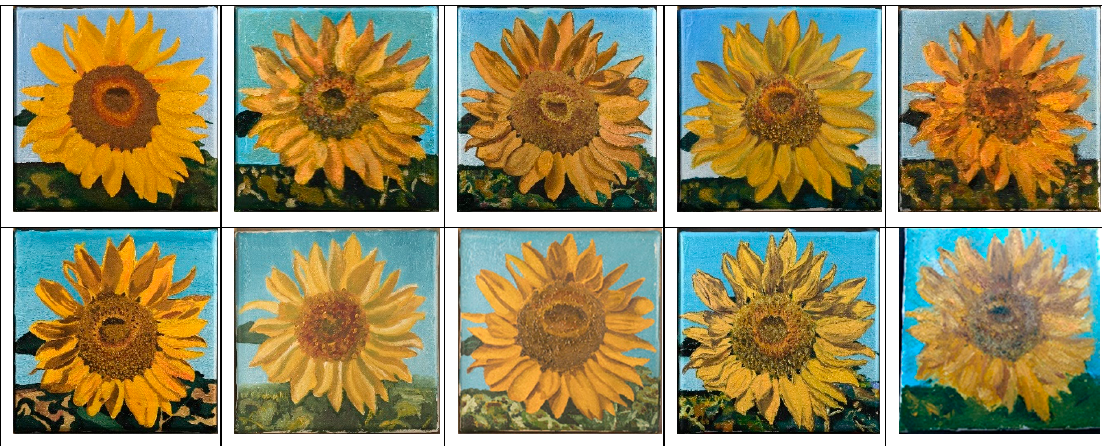
Figure 5 . Paintings for topographical investigation . Figure 5. Paintings for topographical